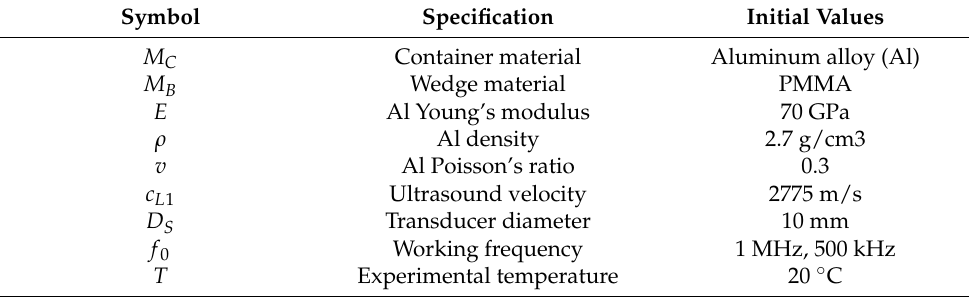
Table 1. Experimental parameters and initial values.